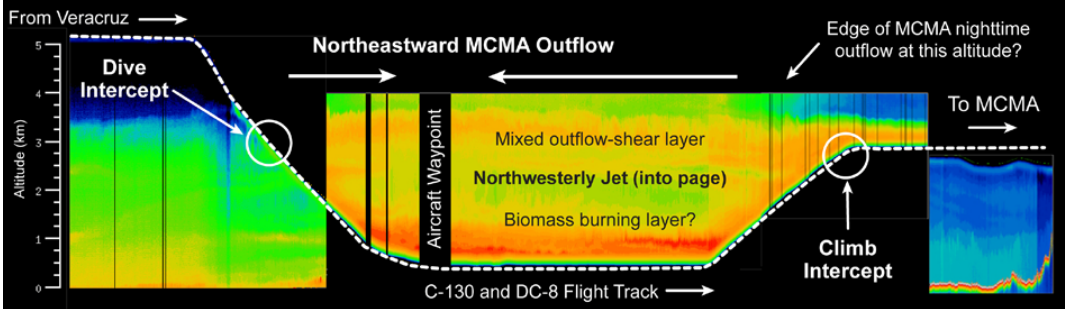
Fig. 13. SABL image from the C-130 dive under probable MCMA outflow near the Veracruz coastline on 19 March. The balloon-based